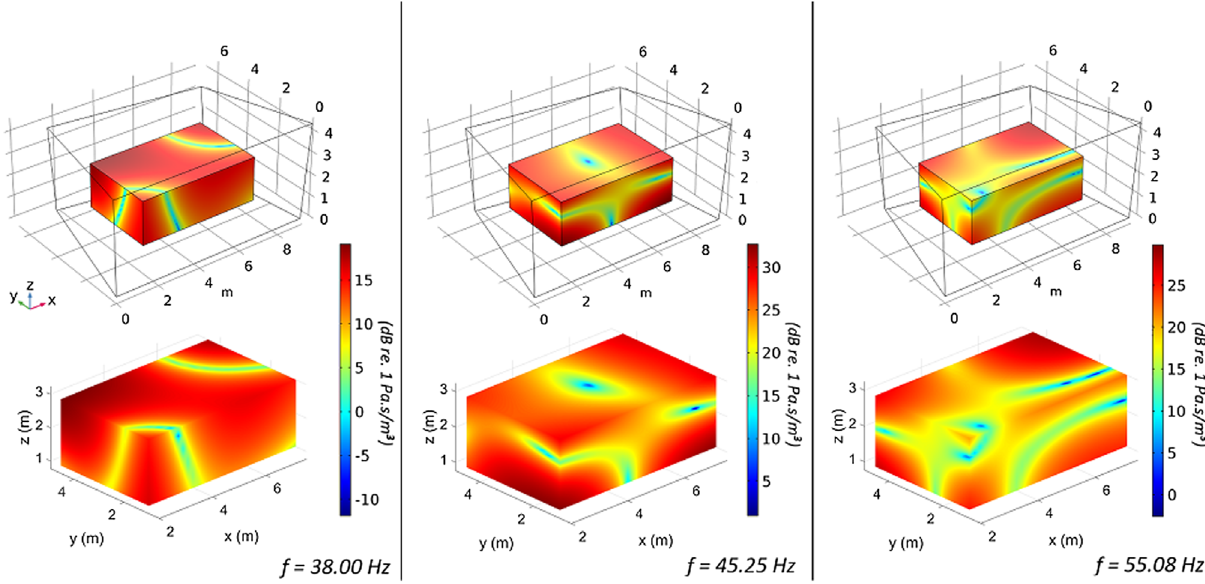
Figure 6. Sound fi eld reconstruction (bottom) at different frequencies for a rectangular area inside the room in comparison with the referencing sound fi elds from numerical simulation